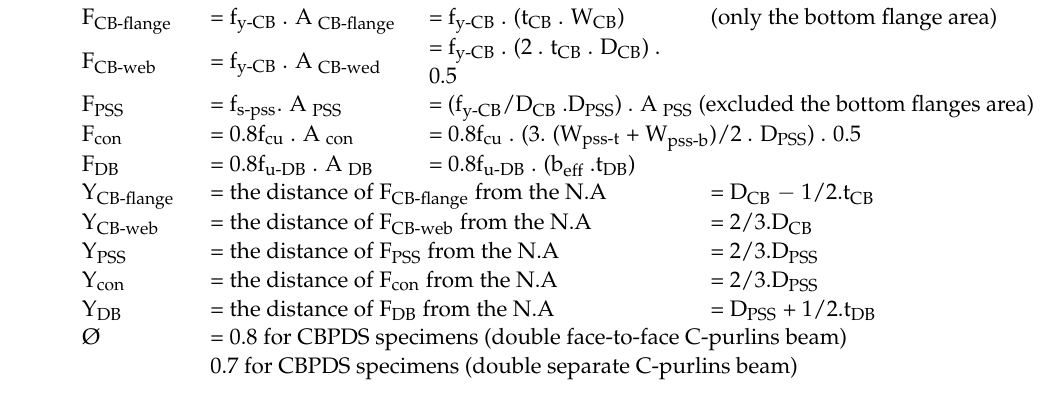
n ) values with the experimental results (M u